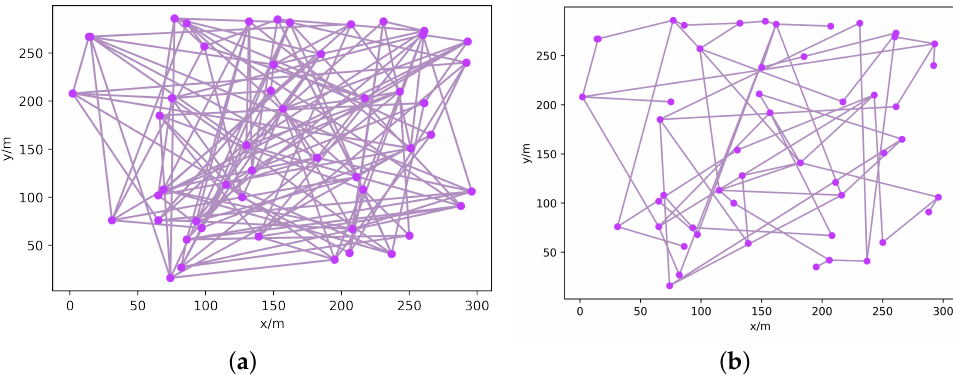
Figure 4. The process of establishing and optimizing the topology. ( a ) Initial Network State. ( b ) Using the game